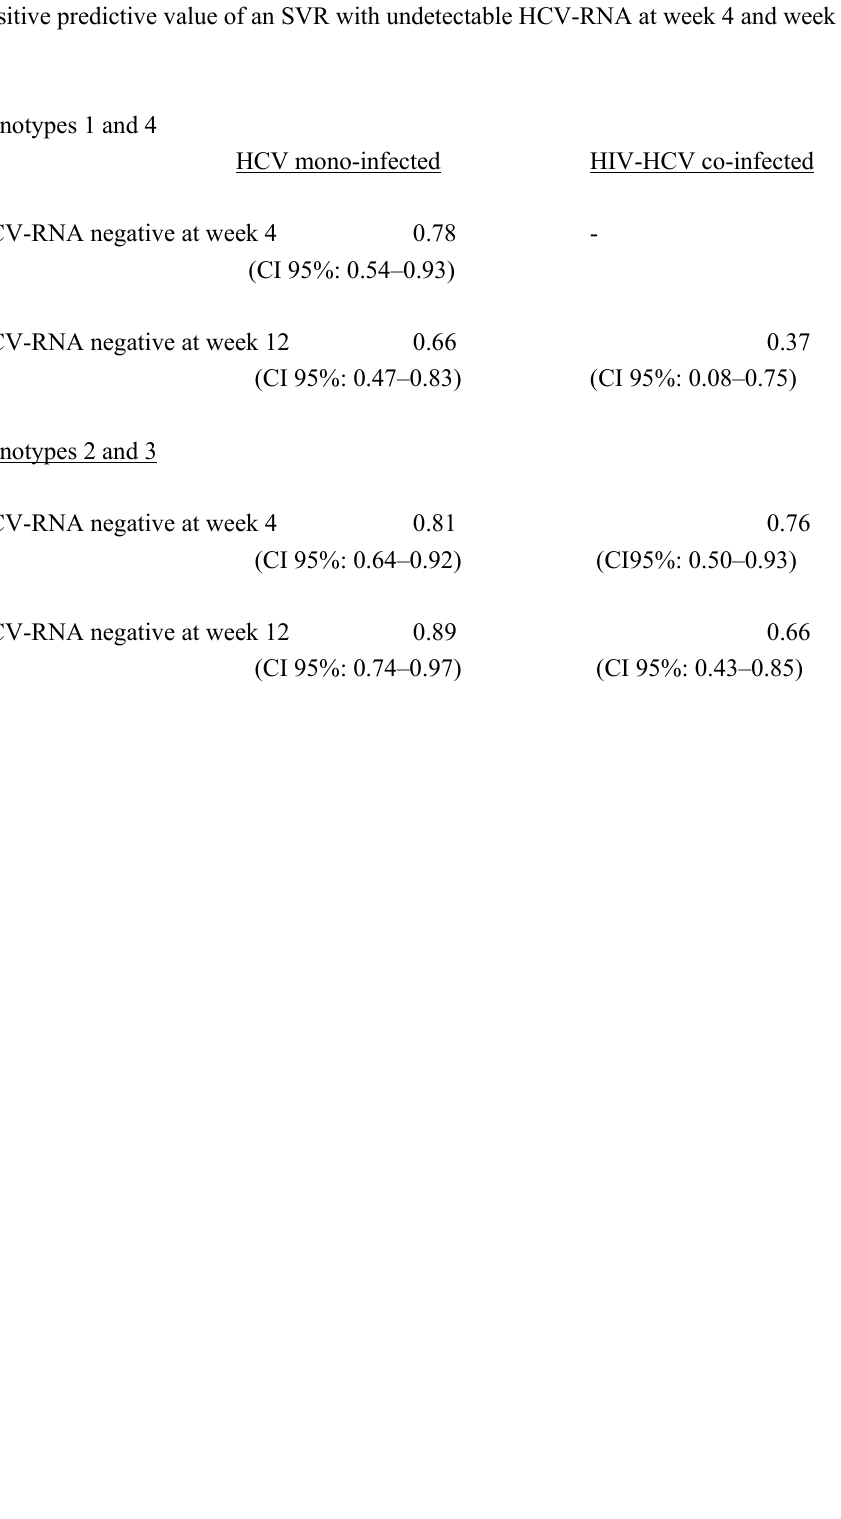
Positive predictive value of an SVR with undetectable HCV-RNA at week 4 and week 12.